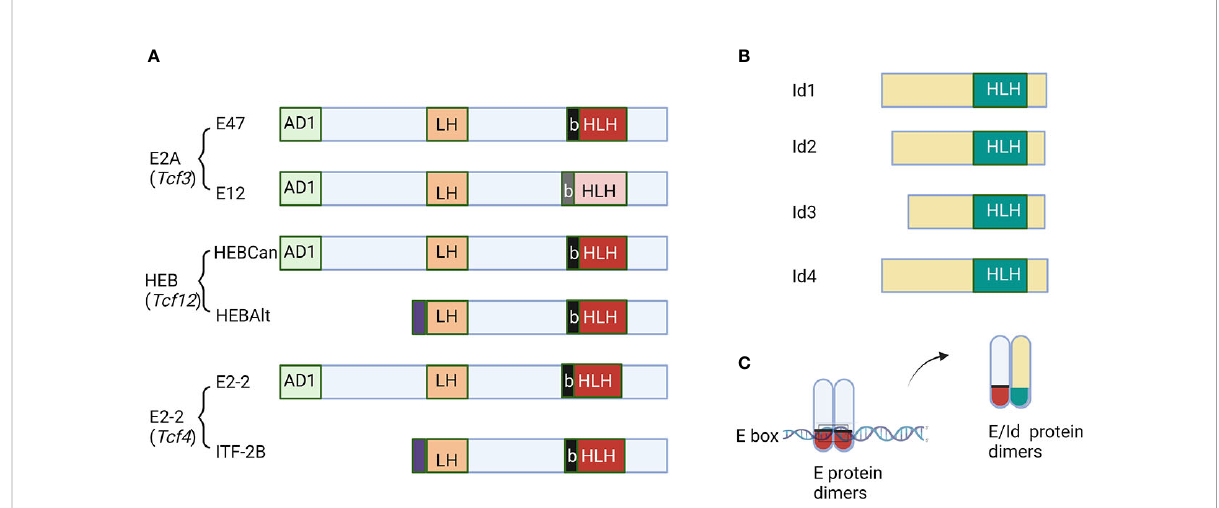
FIGURE 1 Schematic diagrams of E and Id proteins. (A) The function domains of E proteins are labeled. AD1 and LH are two transcription activation domains. The basic and helix-loop-helix domains are marked as b and HLH, respectively. (B) Id proteins with the HLH domain are shown. (C) The mechanism of action of Id proteins to inhibit DNA binding by E proteins. The fi gure was created by